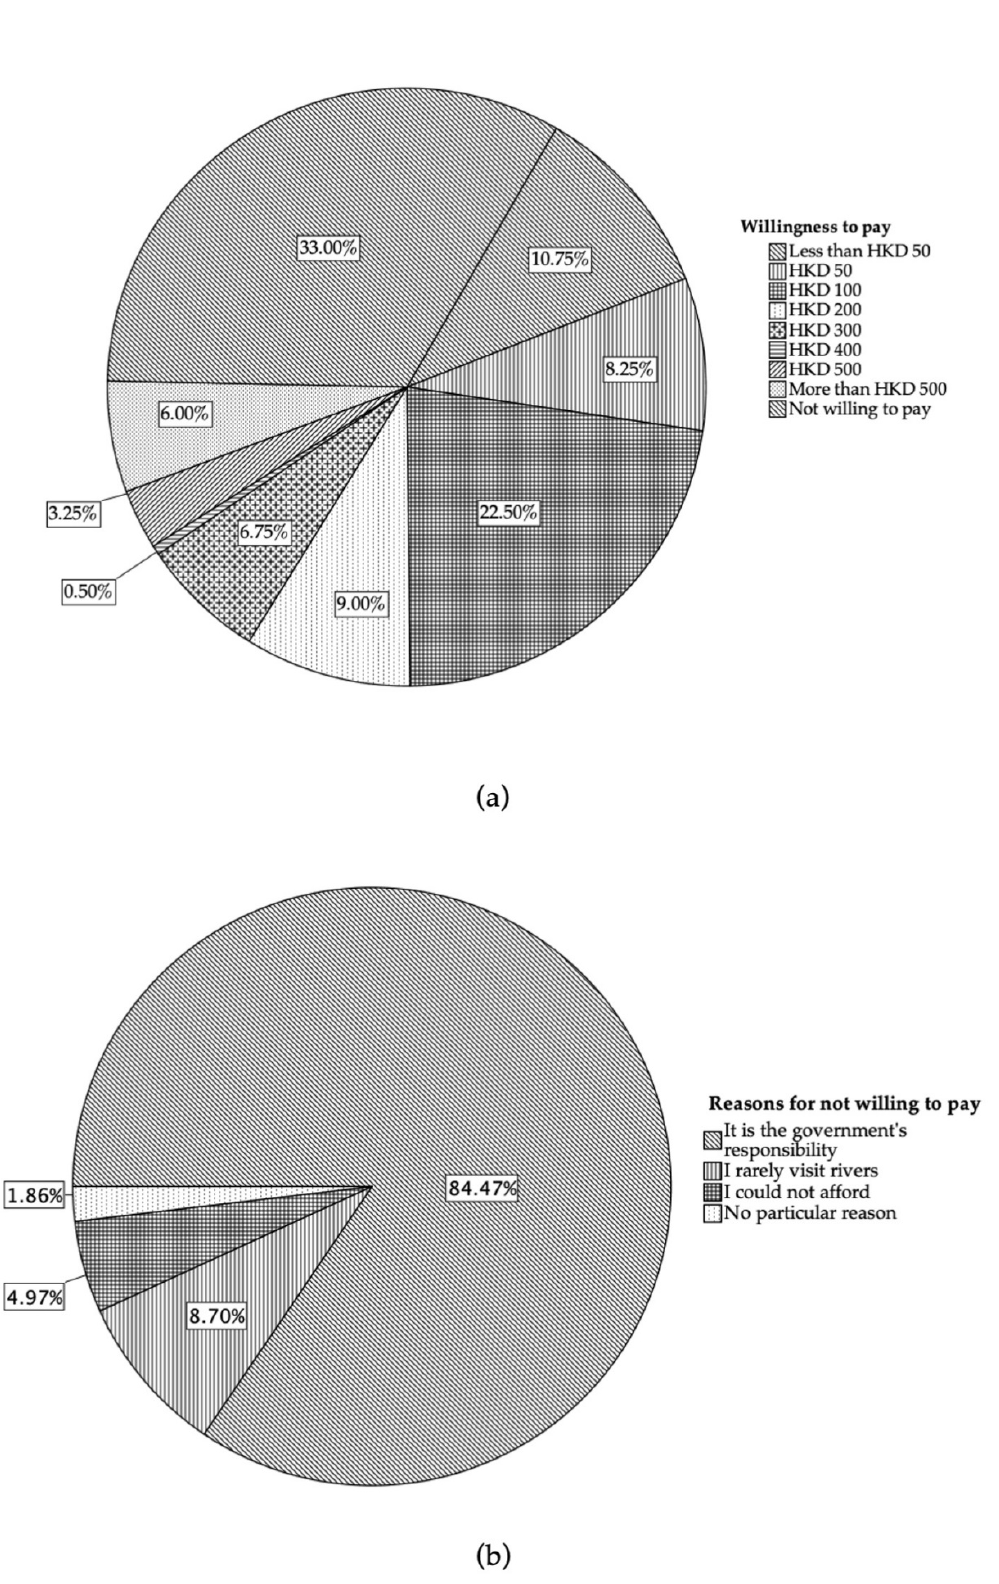
Figure 1. Distribution of amount of willingness to pay ( a ) and reasons of respondents for not willing to pay (negative votes) ( b ).